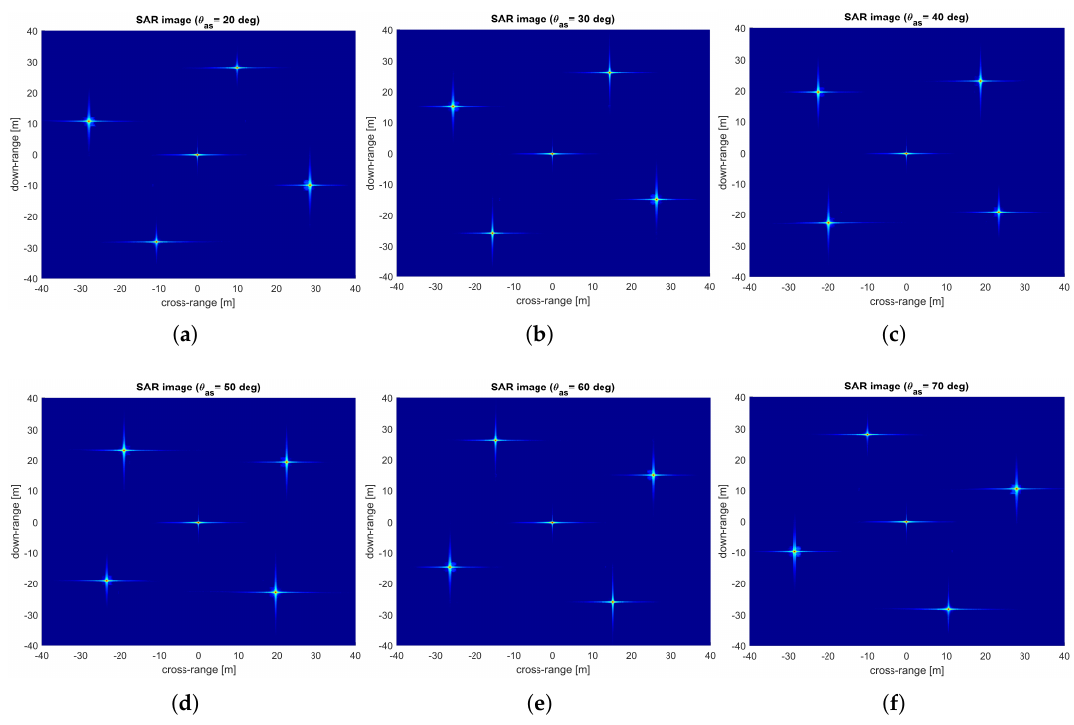
Figure 20. SAR video frame at aspect angle 0°.